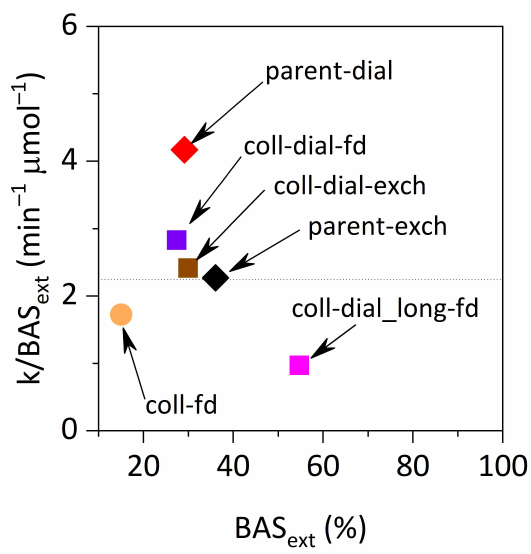
Figure 7. Dependence of the rate constant of Friedel–Crafts alkylation of mesitylene with benzyl alcohol normalized per concentration of the external Brønsted acid sites (k/BAS ext ) on the fraction of external Brønsted acid sites (BAS ext ). The dotted line marks the level for traditionally treated zeolite (calcination followed by ion